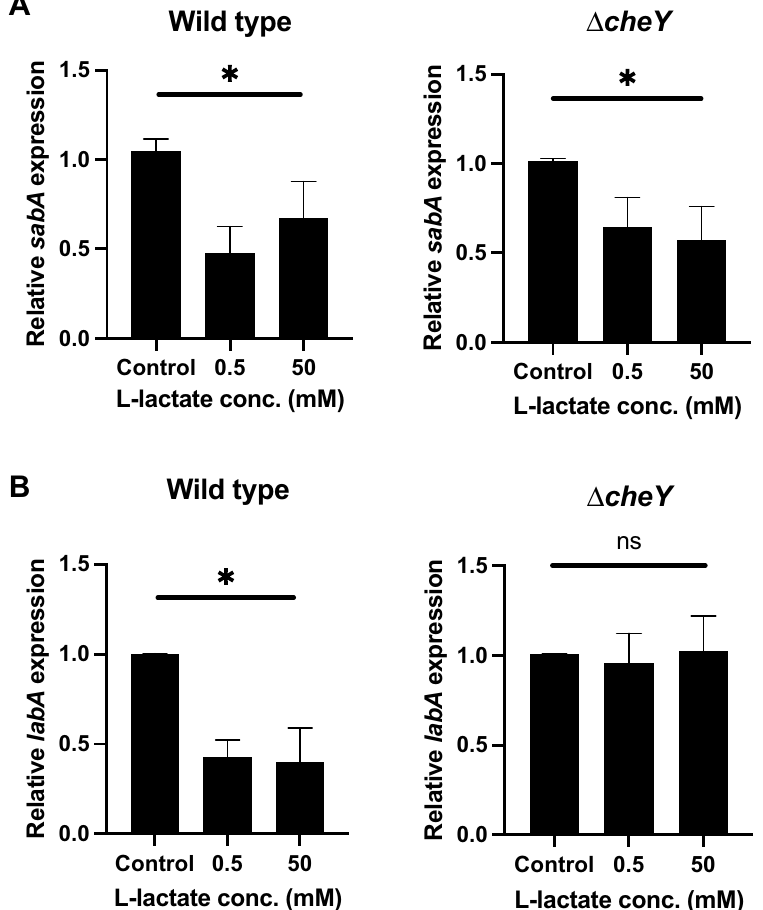
Figure 5. LabA is regulated differently than sabA in the presence of lactate via the CheA/CheY two-component system. Relative expression levels of sabA ( A ) and labA ( B ) in wild-type and ∆ cheY mutant H. pylori after incubation of the bacteria in RPMI 1640 cell culture medium without glucose (control) or supplemented with 0.5 mM or 50 mM l-lactate for 2 h. Target gene expression was normalized to that of the housekeeping gene gyrB . Wild-type and ∆ cheY mutant bacteria were analyzed with their respective controls set to 1 to determine the relative values of sabA and labA expression in each of the samples incubated with lactate. Data represent the means and standard deviation of duplicate samples and are an average of three independent experiments. *P < 0.05; ns, nonsignificant, using ANOVA followed by a Bonferroni